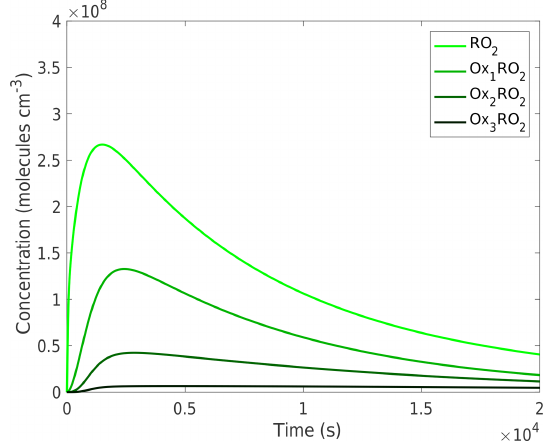
Figure 2. Concentration time series of peroxy radicals (RO 2 ). The peroxy radical concentrations over the course of a simulation peak early as they are produced via α -pinene oxidation and decrease as α -pinene decays and the RO 2 react away. This simulation is run at 298 K and with no NO x , although the trends are similar across the temperatures and NO x concentrations investigated here, with the difference being in the absolute concentrations, especially those of the more oxidized peroxy